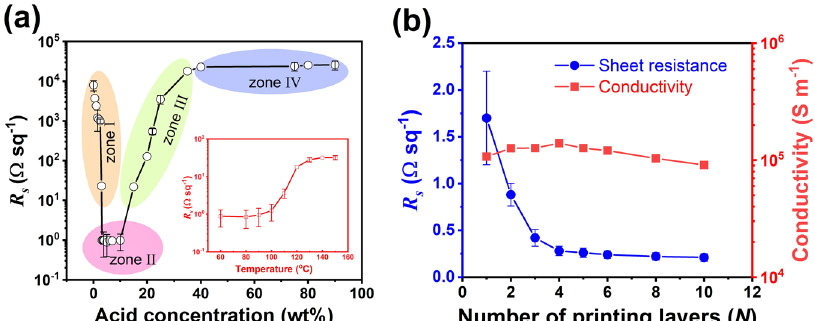
Fig. 2 Optimization of the curing conditions. a Sheet resistance variation with different acid concentrations inside the curing reagent. The samples are dried on the printer stage at 60 °C (inset: effect of post-annealing of the sample cured by 5 wt% acids. Lines are guided for the eye). b Variations of the sheet resistance and the electrical conductivity with a number of printed layers where samples are cured by 5 wt% acid at 60 °C. The error bars presented in the plots are standard deviations of the respective measurements. Lines are guides for the